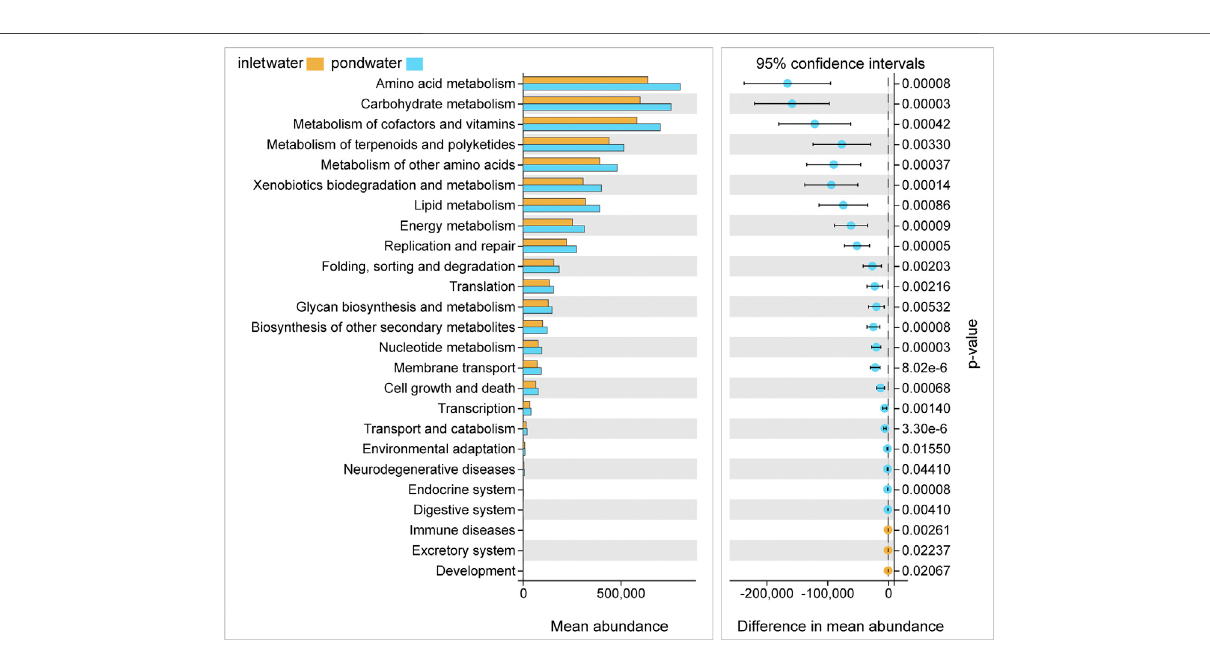
FIGURE 4 | Predicted potential functions of bacterial communities and signi fi cant difference ( p < 0.05) analysis of functions in inlet water and pond water.